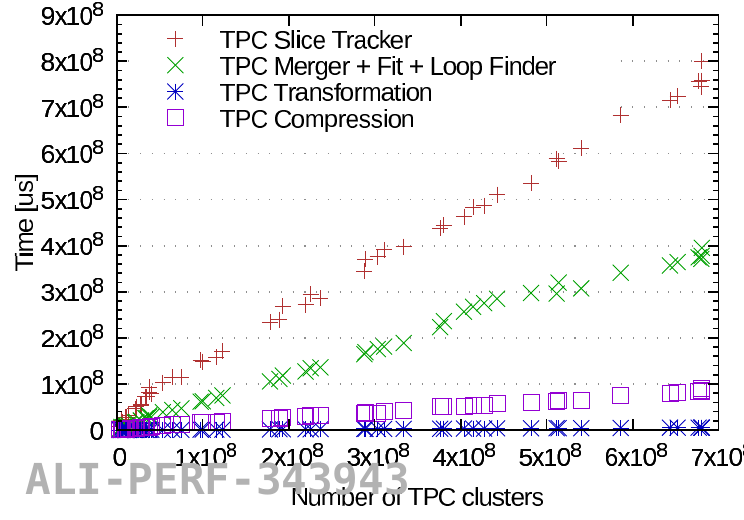
Figure 4. Performance of several GPU reconstruction steps versus size of input